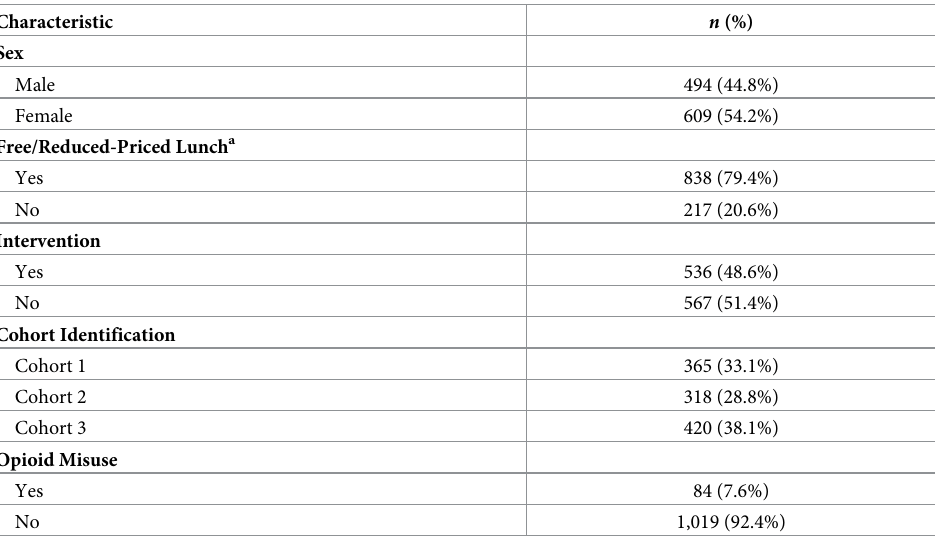
Table 1. Sample characteristics ( N =